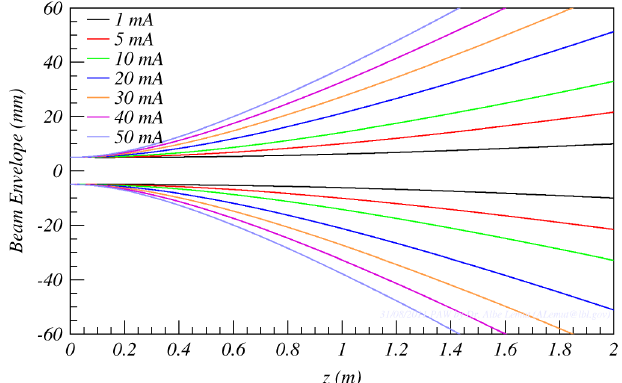
FIG. 3. Beam envelope growth for 4 He þ 50 keV initially quasiparallel ( (cid:3) 4 rms ¼ 4 (cid:2) mm mrad , beam envelope divergence 0.7 mrad), 0.5 cm radius, uniform, free drifting beams (neutral- ization 90%) at selected currents. The 50 mA beam reaches a 2 cm radius after 0.6